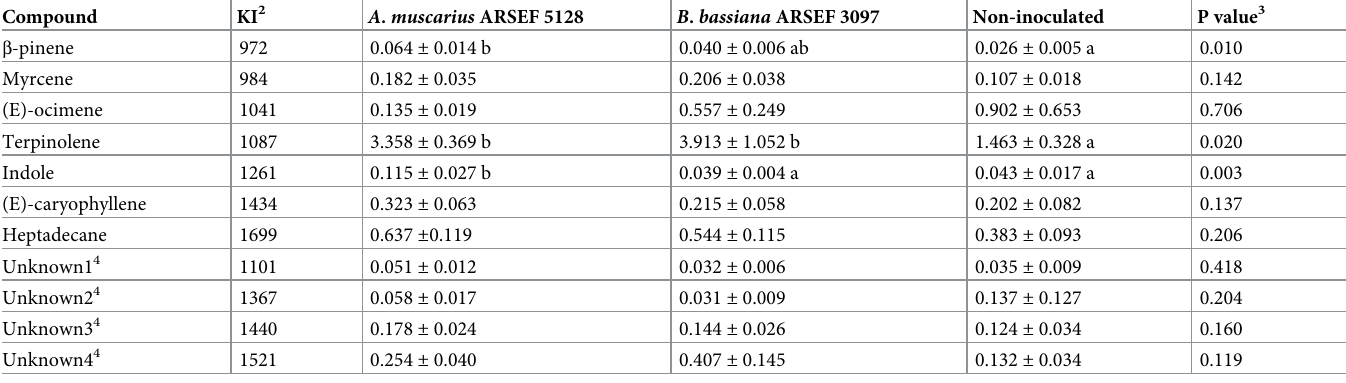
Table 1. Amounts 1 of volatile compounds identified by GC-FID/GC-MS analysis from the headspace of sweet pepper plants inoculated with Akanthomyces muscar- ius ARSEF 5128 or Beauveria bassiana ARSEF 3097, compared to non-inoculated plants.